Question: What form of chart is displayed?
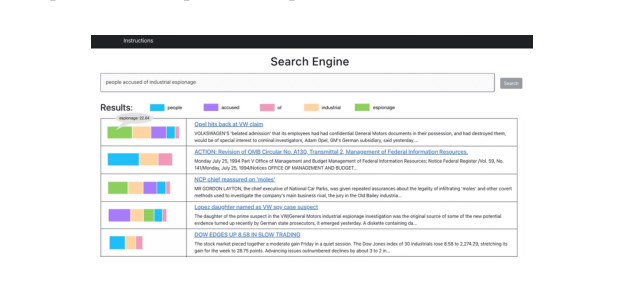
Answer: bar